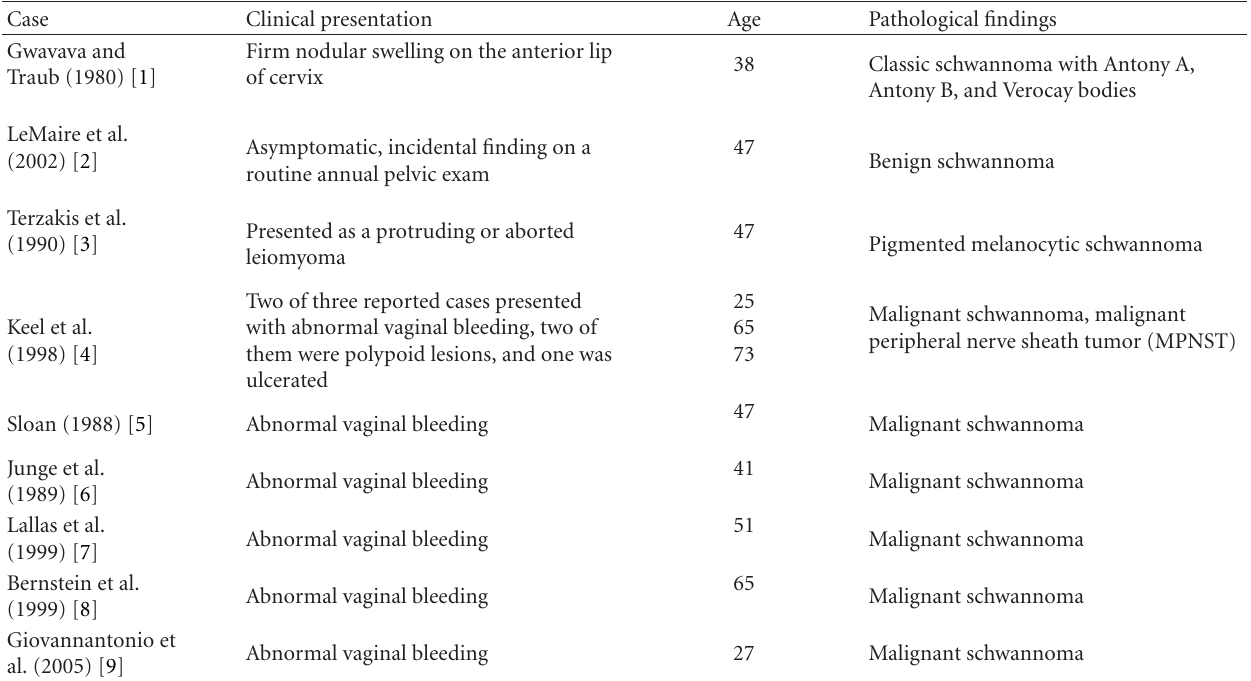
Table 1: Summary of the previously reported primary schwannoma of the uterine